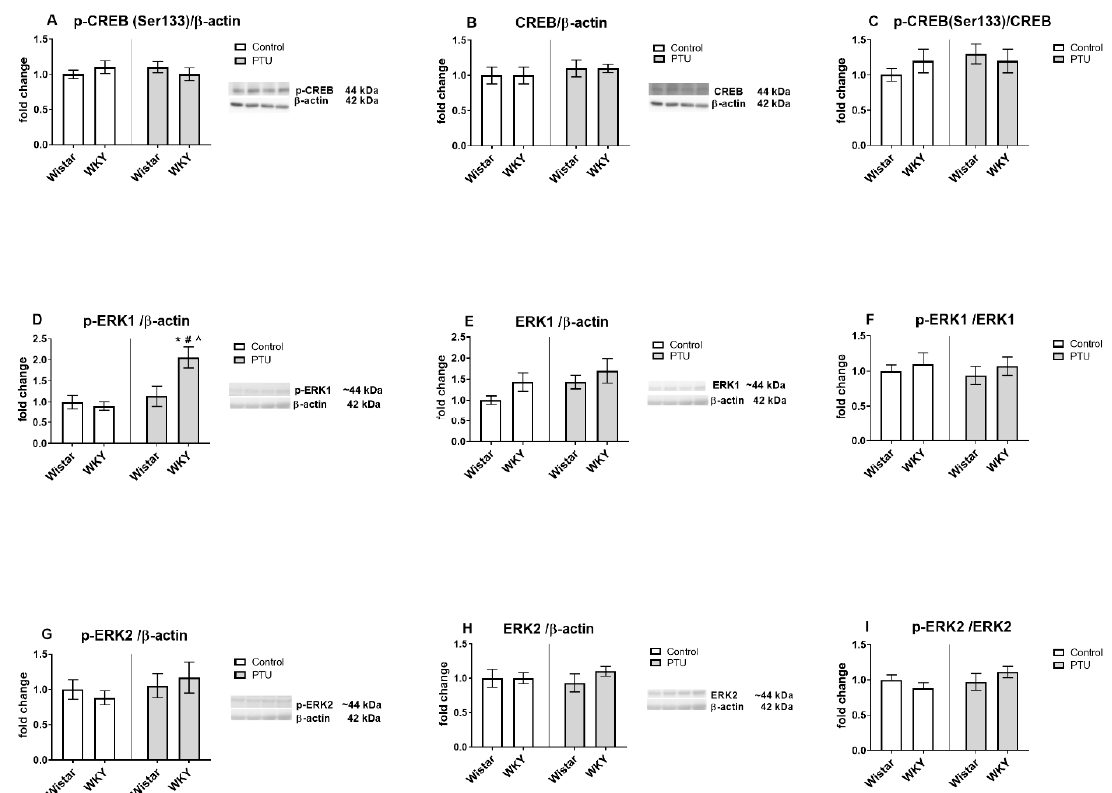
Figure 7. The effects of strain and PTU treatment on the protein levels of phospho-(Ser133) CREB ( A ), CREB ( B ), phospho- CREB (Ser133)/CREB ( C ), phospho-ERK1 ( D ), ERK1 ( E ), phospho-ERK1/ERK1 ( F ), phospho-ERK2 ( G ), ERK2 ( H ), and phospho-ERK2/ERK2 ( I ) in the hippocampus. The results are expressed as the average fold change ± SEM. * p < 0.05 vs. the control group (Wistar rats); # p < 0.05 vs. the WKY group, ˆ vs. the Wistar PTU group. n = 8–10.